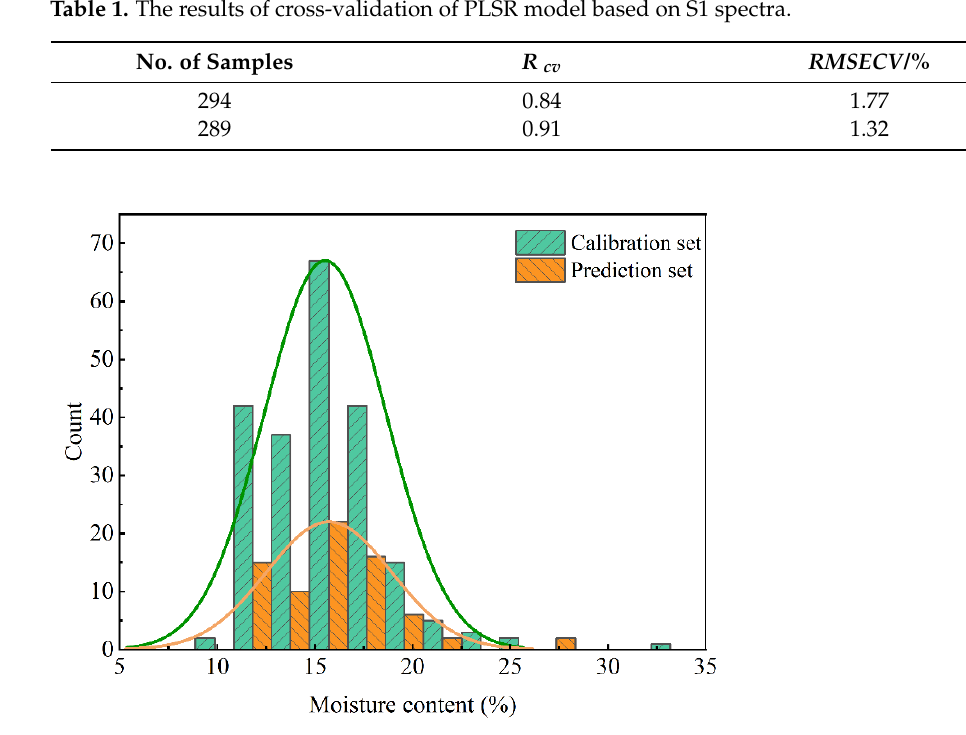
Figure 4. The histogram of moisture content values of all maize seeds.